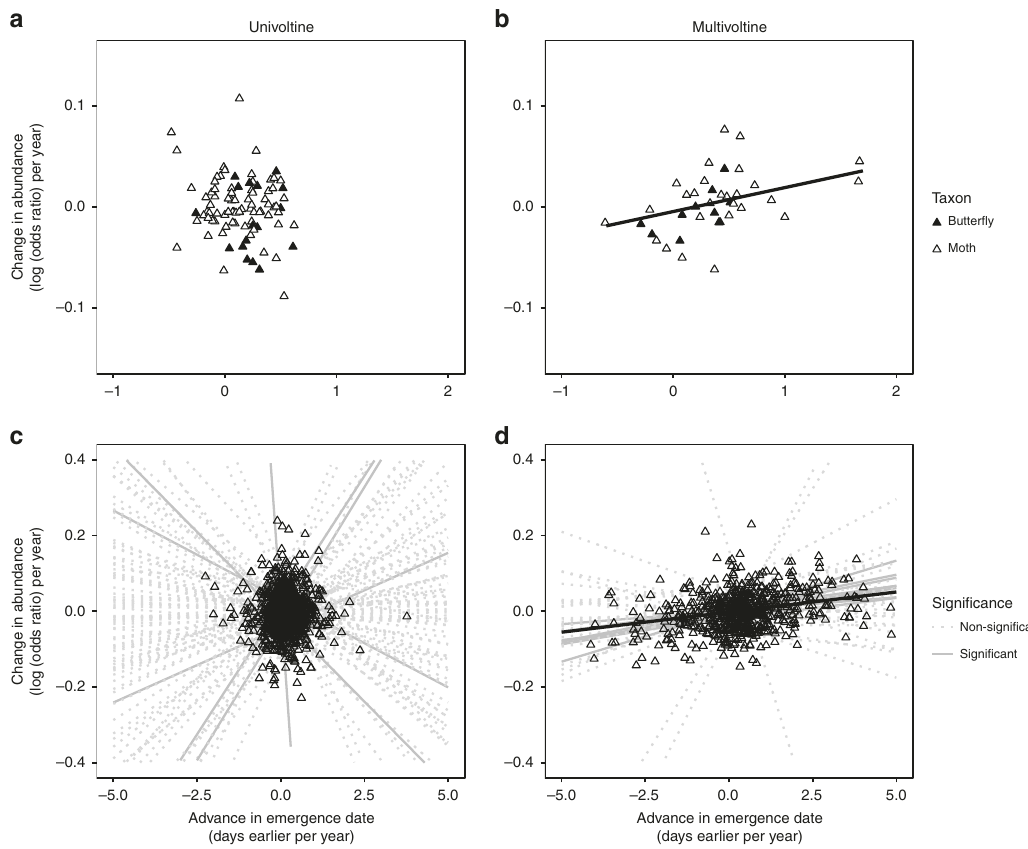
Fig. 2 Phenology advances and voltinism drive abundance trends in multivoltine species. Advancing phenology correlates with increasing abundance at species- and population-level for multivoltine species ( n = 39), but not univoltine species ( n = 91). Lines depict model-predicted relationships between phenology and abundance trends, from generalised linear mixed-effects models. a , b Points show changes in phenology and abundance over the study period (1995 – 2014) at species-level for univoltine and multivoltine species, respectively. Point colour indicates taxonomic group (butter fl ies: fi lled, moths: open). Lines show signi fi cant ( P < 0.05) relationships. c , d Points show changes in phenology and abundance over the study period at the population level. Grey lines show relationships calculated independently for each species; lines are solid if the relationship is signi fi cantly different to zero ( P < 0.05), or otherwise are dotted. Solid black lines indicate the overall relationship across species, and are plotted only if signi fi cant ( P < 0.05). Among univoltine species ( c ), 3/91 (3.3%) show a signi fi cant positive relationship, and 3/91 (3.3%) a signi fi cant negative relationship, between phenology and abundance change; the average relationship across species is not signi fi cant (Table 2). Among multivoltine species ( d ), 8/39 (20.5%) show a signi fi cant positive relationship between phenology and abundance change, and none show a signi fi cant negative relationship; the average relationship across species is also signi fi cantly positive (Table